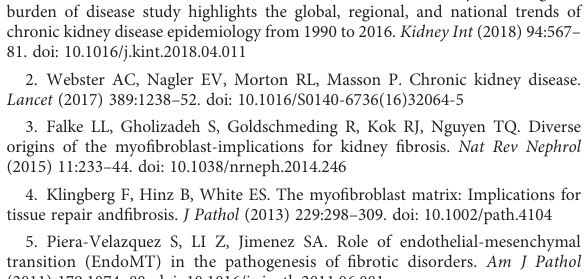
SUPPLEMENTARY FIGURE 1 ESA inhibited aldosterone-induced cell proliferation in mice. Immunohistochemical staining using antibodies against Ki-67 to examine cell proliferation (n=6). The data are presented as the mean ± SD, *p < 0.05 vs. CON, #p < 0.05 vs. ALD. SUPPLEMENTARY FIGURE 2 Macrophage proliferation in the kidneys of UNX + ALD-infused mice. Immuno fl uorescent staining of kidney sections with antibodies against the macrophage marker F4/80 (FITC, green) and the proliferating cell nuclear antigen marker Ki-67 (TRITC, red) to identify proliferating macrophages, and nuclei were stained with DAPI in blue. SUPPLEMENTARY FIGURE 3 The reduction of serum K + level in UNX + ALD-infused mice. Serum K + level was measured by protein hydrolysis enzyme method. The data are presented as the mean ± SD, *p < 0.05 vs. CON, #p < 0.05 vs.